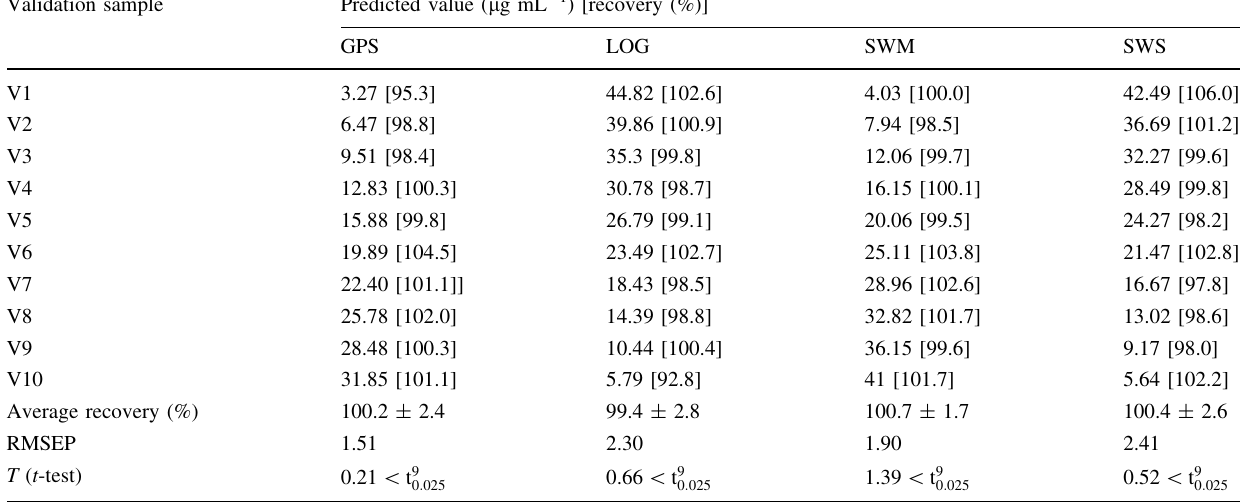
Table 3 Predicted concentrations of validation samples Validation